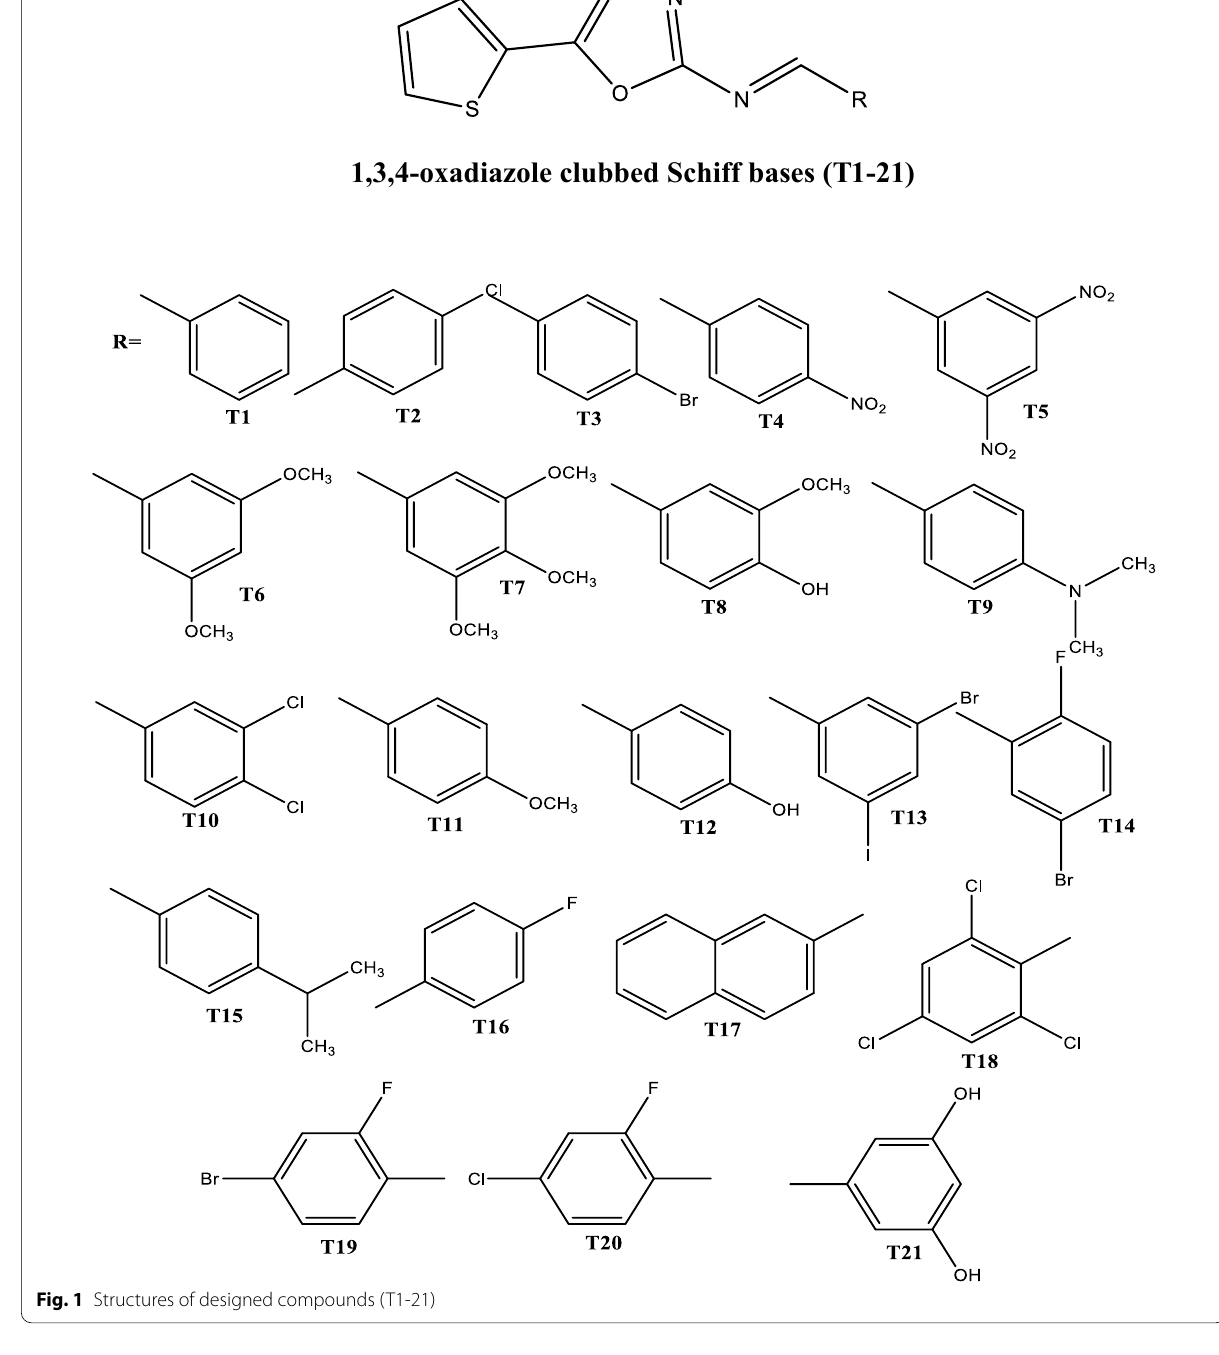
Fig. 1 Structures of designed compounds